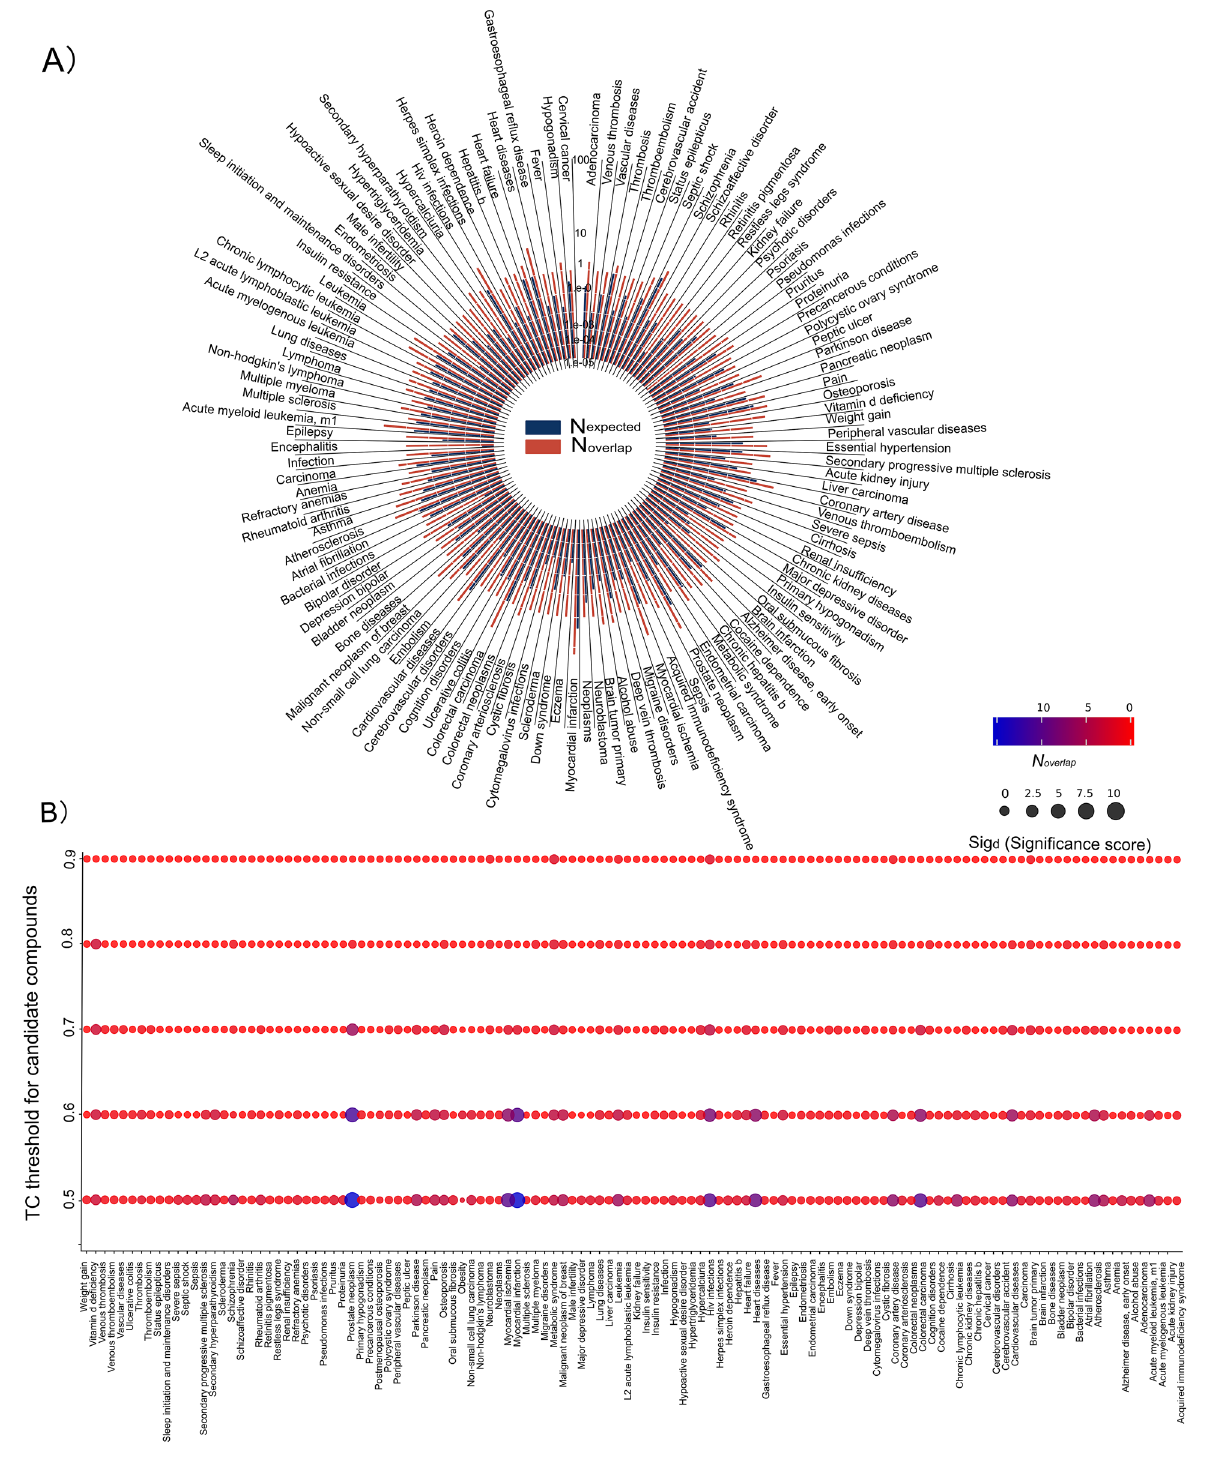
Figure 3. ( A ) The circular bar shows drug repurposing results matched with CTD. All the matched diseases were distributed as pie in the circle. The blue bars represent ( N expected ) the expected number of compounds, if chosen randomly while the red bar represents the actual overlap (N overlap ) between compounds in CTD and DrugRepo. ( B ) The Significance scores at different TC thresholds (with Y-axis as thresholds and X-axis as a disease whose true positive is not 0). The significance score is represented by dot size, and the colour from red to blue represents number of overlapping